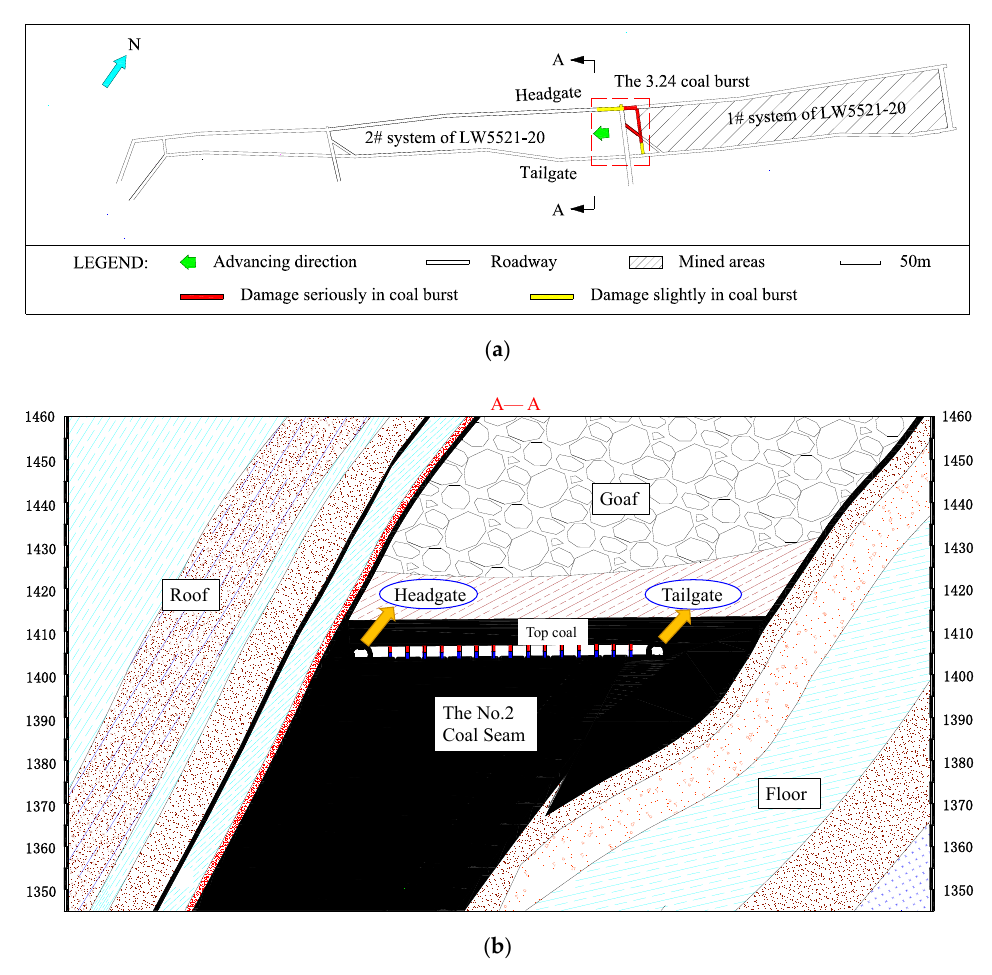
Figure 1. Layout of the 5521 ‐ 20 working face: ( a ) Layout of the working face; and ( b ) A—A Profile.